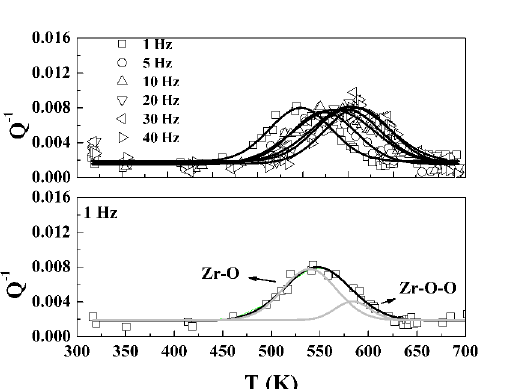
Figure 3. Peak decomposition of the Ti-15Zr-15Mo alloy.